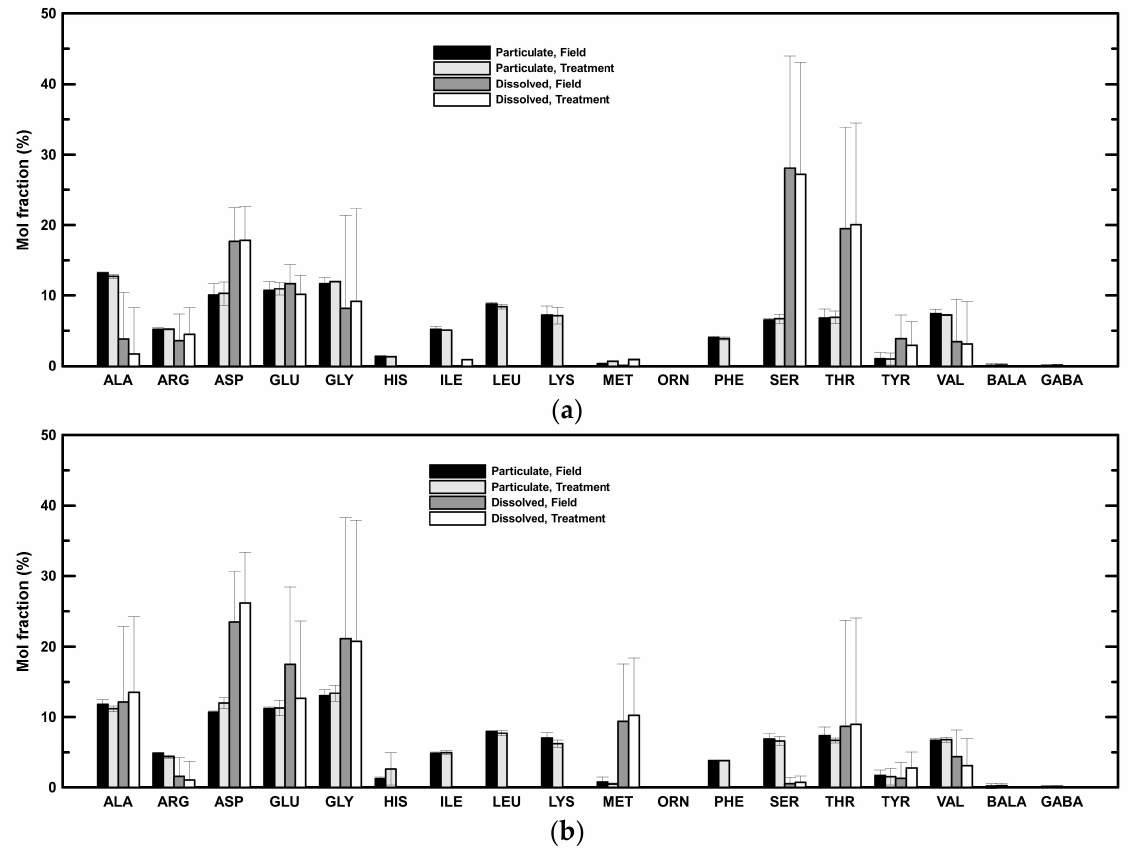
Figure 4. Mol fractions of individual amino acids. ( a ) Averaged mol fractions of amino acids in low-salinity samples. ( b ) Averaged mol fractions of amino acids in high-salinity